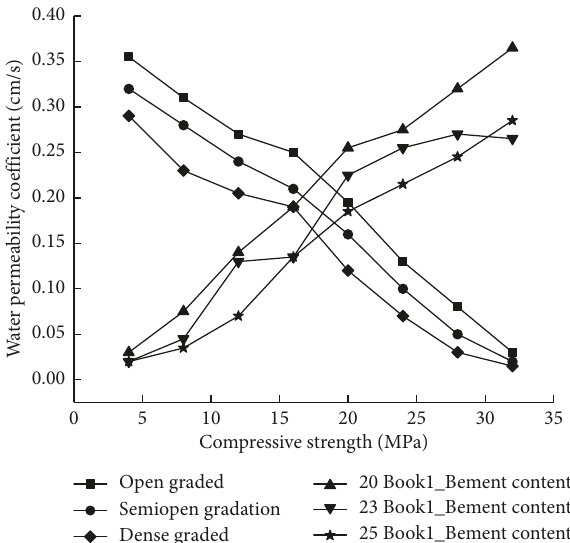
Figure 16: Comprehensive relationship between grading type, strength and permeability coefficient.